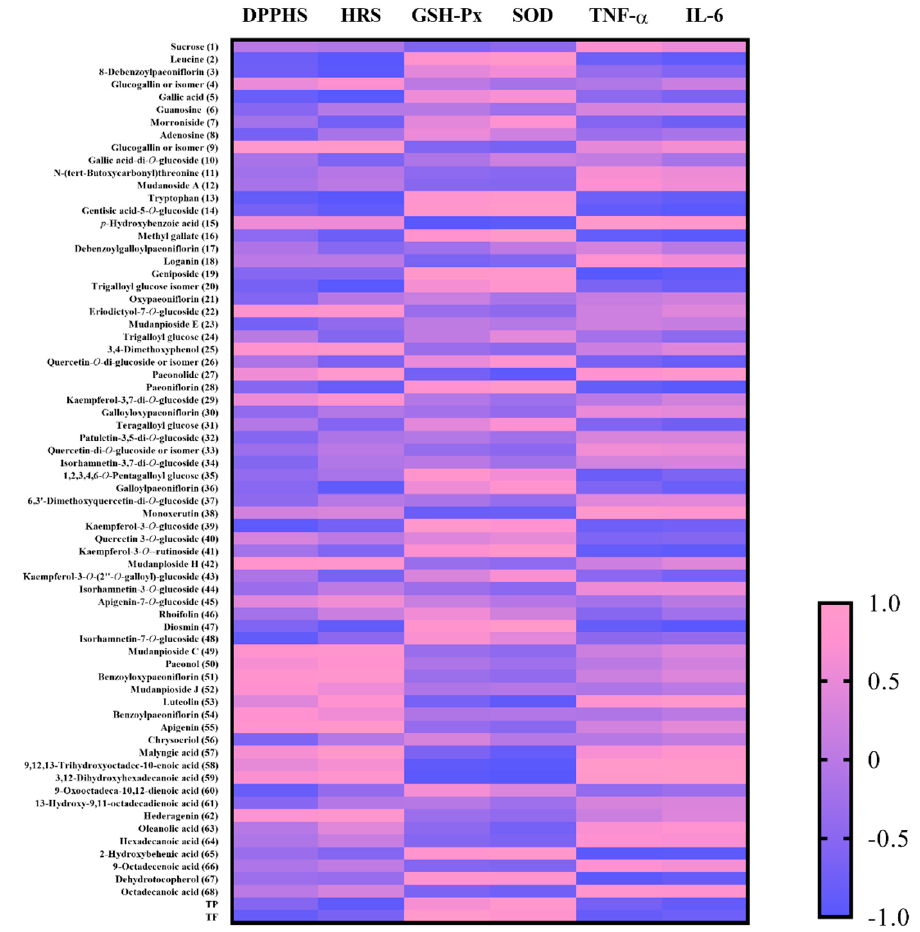
Figure 6. Correlation analysis between phytochemicals and bioactivities. The numbered compounds were consistent with that in Table 2. DPPHS: DPPH scavenging; HRS: hydroxyl radical scavenging.